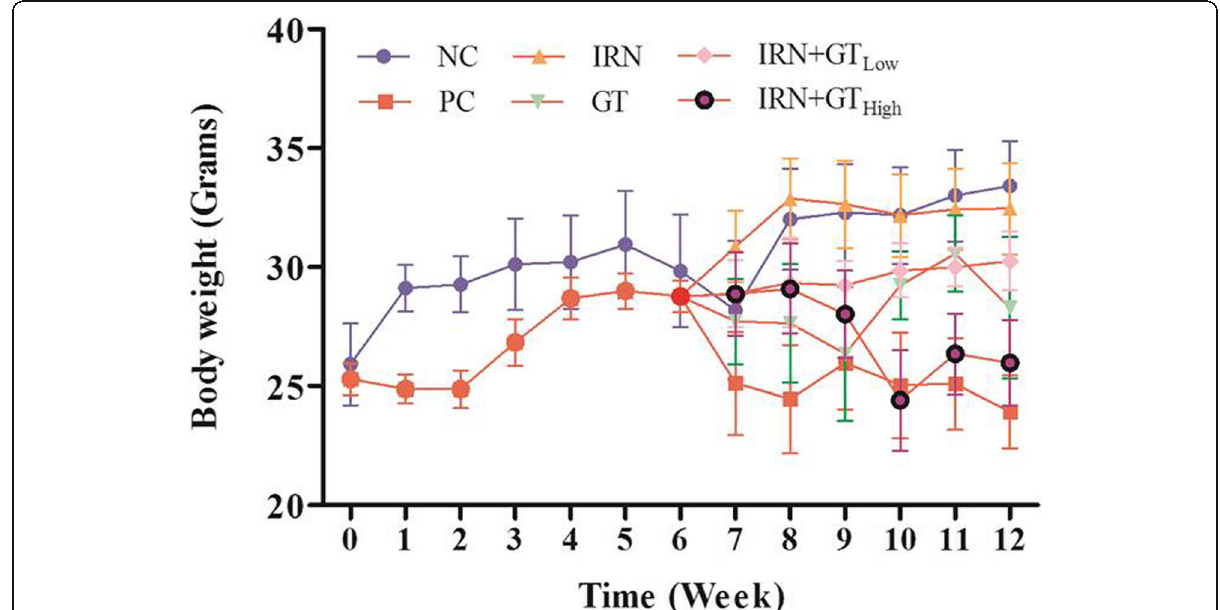
Fig. 2 Effect of IRN and GT on body weight gain during the 12-week treatment period. Values were presented as mean ± SEM, # p < 0.05, ## p < 0.01, and ### p < 0.01 when compared to the PC group and * p < 0.05, ** p < 0.01, and *** p < 0.001 when compared to the IRN group. Increase in bodyweight was recorded in the IRN group when compared to the PC group after 12 weeks. Body weight gain was recorded to be minimal in the IRN +